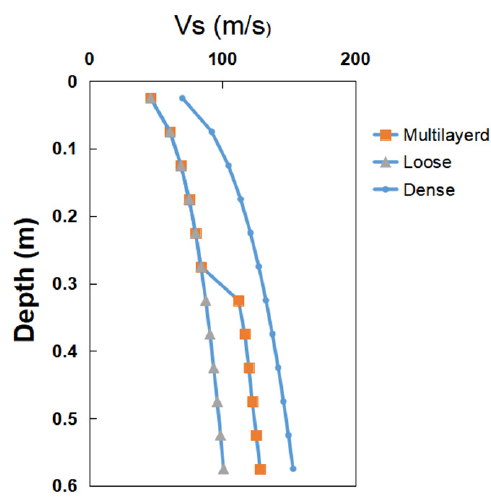
Figure 9. The shear wave velocity modulus of loose ground and dense ground. The shear wave velocity at the lower part of the single ground receives a higher vertical stress than the shear wave velocity at the lower part of the multilayered ground. Since the upper part of the multilayered ground is made of loose ground with low unit weight, and the vertical loading was applied to the lower part, so the shear wave velocity of the multilayered ground is lower than the shear wave velocity of the dense ground. To evaluate the amplification characteristics of the multilayered flat model ground, the peak ground acceleration (PGA), spectral acceleration (SA), and amplification factor for the three input seismic waves were analyzed. Figure 10 shows the PGA by depth measured at the center of the flat, multilayered ground model. Under the three waveforms, the depth range of 0.3–0.6 m is dense ground, and the peak ground acceleration changes little with the decrease in depth. The depth range of 0–0.3 m is loose ground, and the peak ground acceleration increases obviously with the decrease in depth. Among them, the Sine 10 Hz wave does not show a steep shape even on the upper ground, because it is different from the natural period of the ground and cannot generate resonance. Artificial seismic waves and the sine wave resonate in the upper ground.